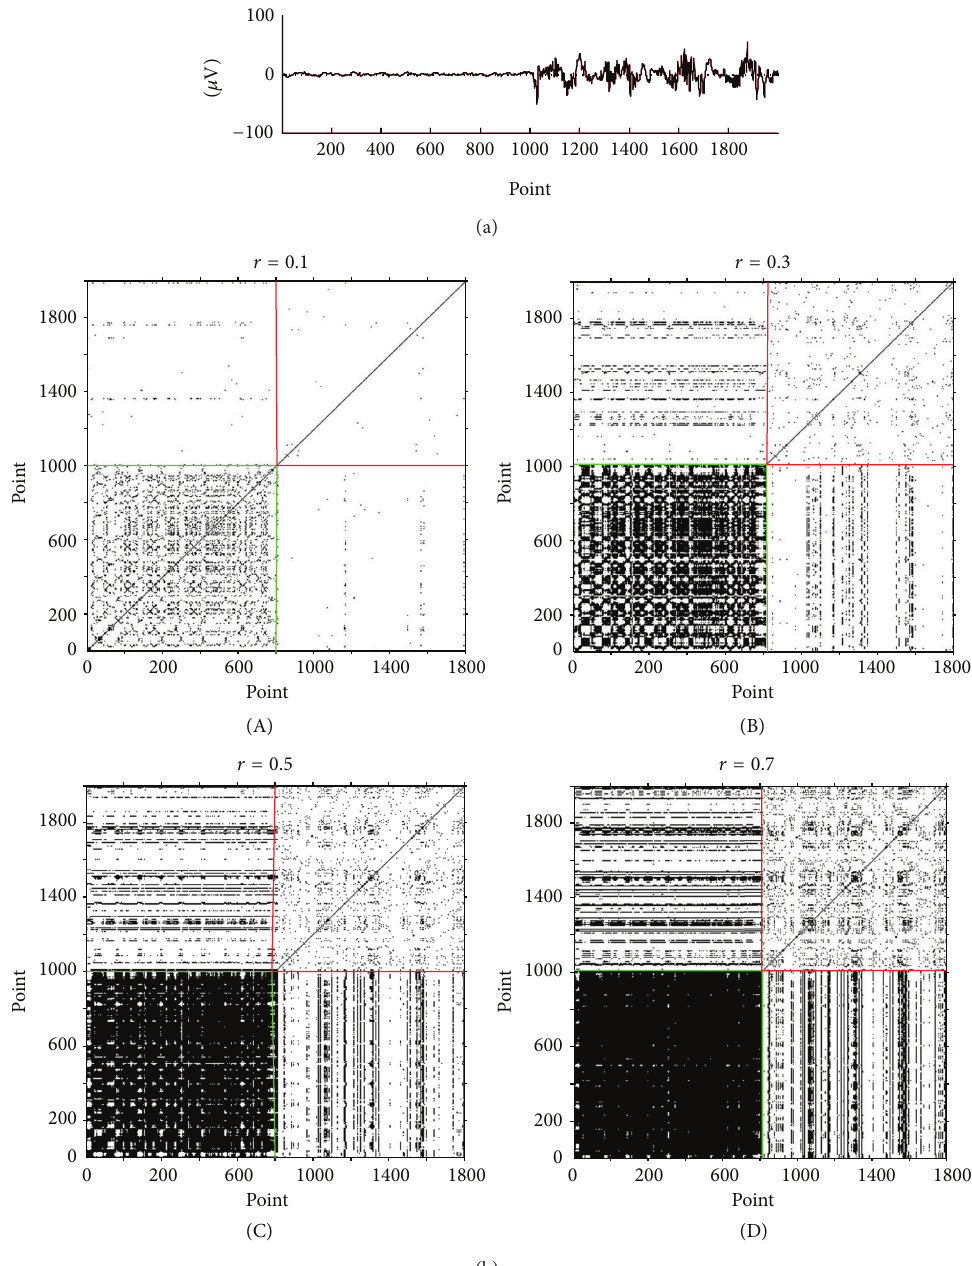
Figure 4: (a) An EEG signal consists of suppression and burst; (b) the different RP under four different radiuses for the signals in (a). (A) 𝑟 = 0.1 , (B) 𝑟 = 0.3 , (C) 𝑟 = 0.5 , and (D) 𝑟 = 0.7 with a dimension of 4 and a delay of 3.